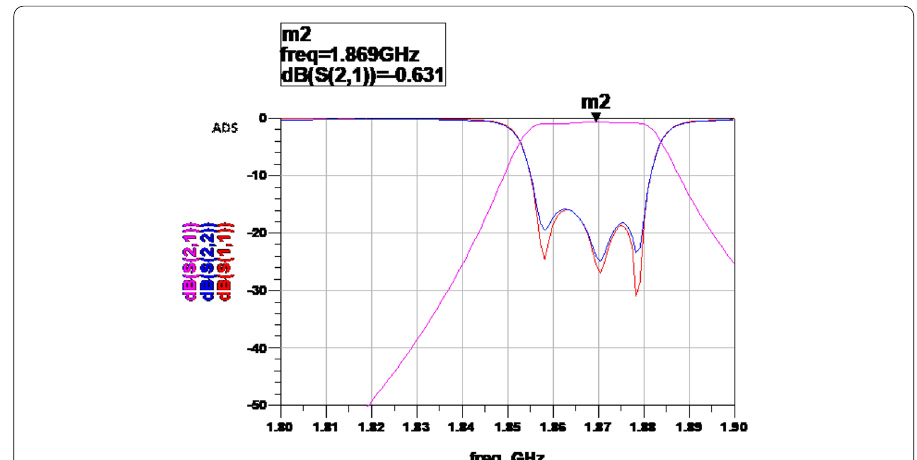
Fig. 17 Measured output band pass filter S-parameter. The insertion loss is about 0.63 dB at 1.87 GHz, with 30 dB attenuation at 1.835 GHz and 1.95 GHz. The bandwidth of the filter is about 30